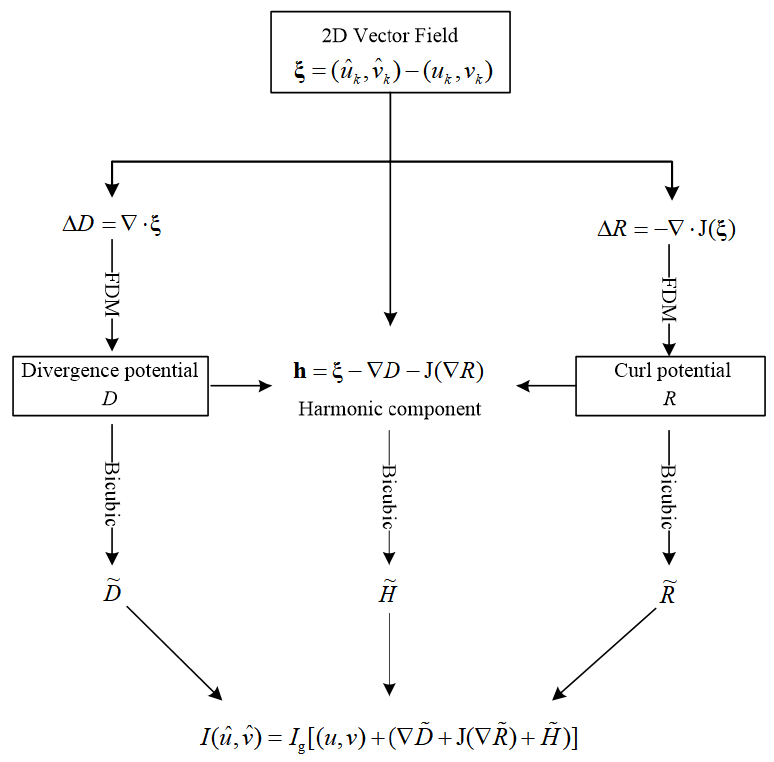
Figure 9. Flow chart of image recovery algorithm based on HHD.